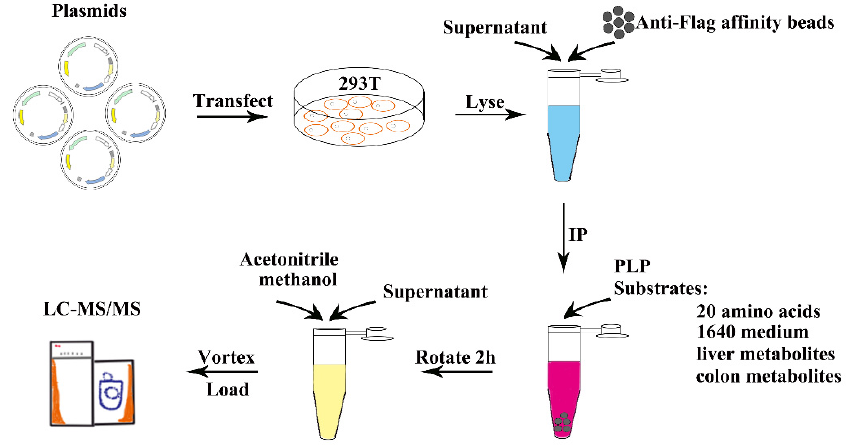
Figure 2. Workflow for the substrate identification of amino acid decarboxylase. IP, immunoprecipi- tation; PLP, Pyridoxal Phosphate.